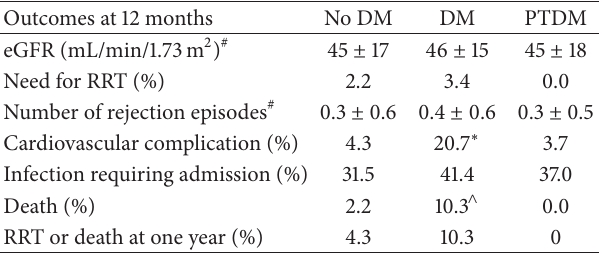
Table 4: Outcomes at 12 months following